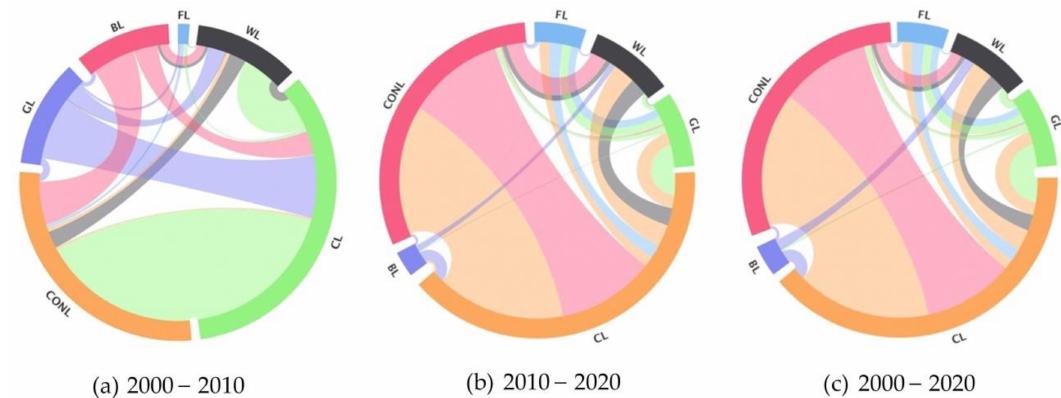
Figure 3. Chord diagram of land use changes in typical areas of the Yellow River Basin from: ( a ) 2000–2010, ( b ) 2010–2020, and ( c )